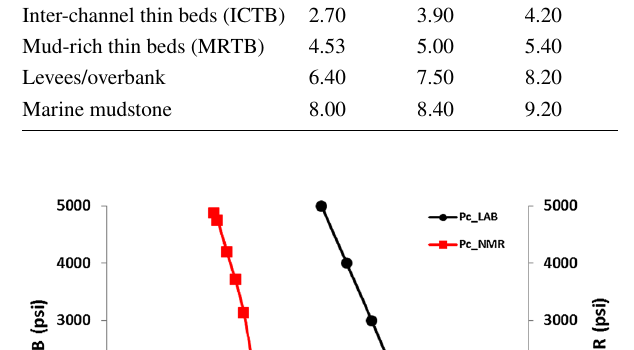
Fig. 15 Plot of mercury injection capillary pressure and inverse NMR T 2 relaxation for the channel storey axis unit for a fully saturated sam- ple. This indicates a fair relationship between capillary parameters that requires a recalibration for improved fit